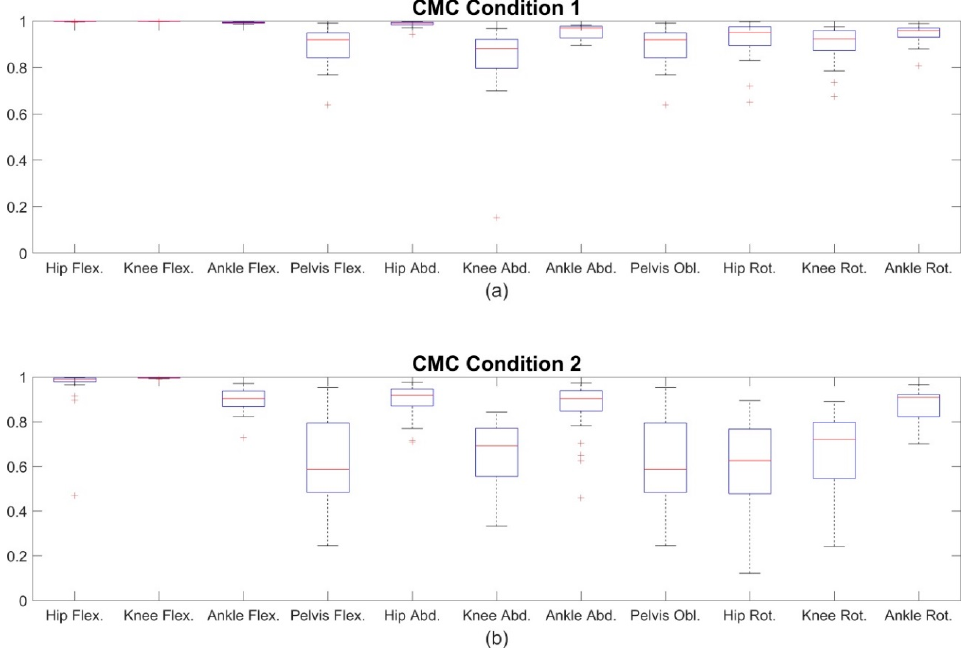
Figure 4. Mean coefficient of multiple correlation (CMC) values over all subjects of section A for condition 1 ( a ) and condition 2 ( b ). Exemplary only the joint angles of the left lower extremity are shown. Table 3. Results of the paired t -test for RMSE and ROME of every joint and all three sections. Bold values indicate non-significant differences between condition 1 and condition 2. RMSE ROME RMSE